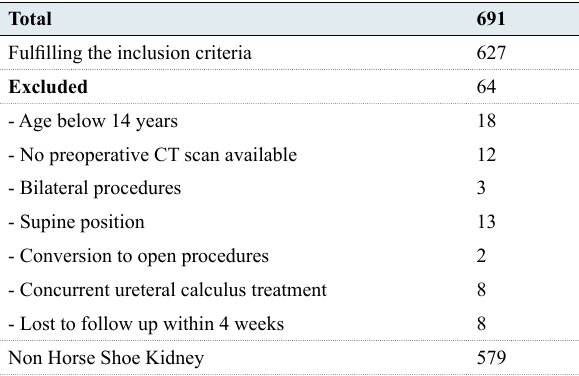
Table 1: Reason for exclusion from the study among patients undergoing PCNL during the study period